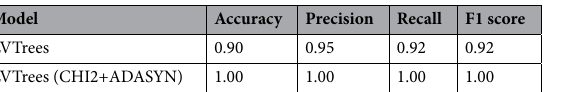
Table 15. Performance of proposed approach on Leukemia_GSE9476